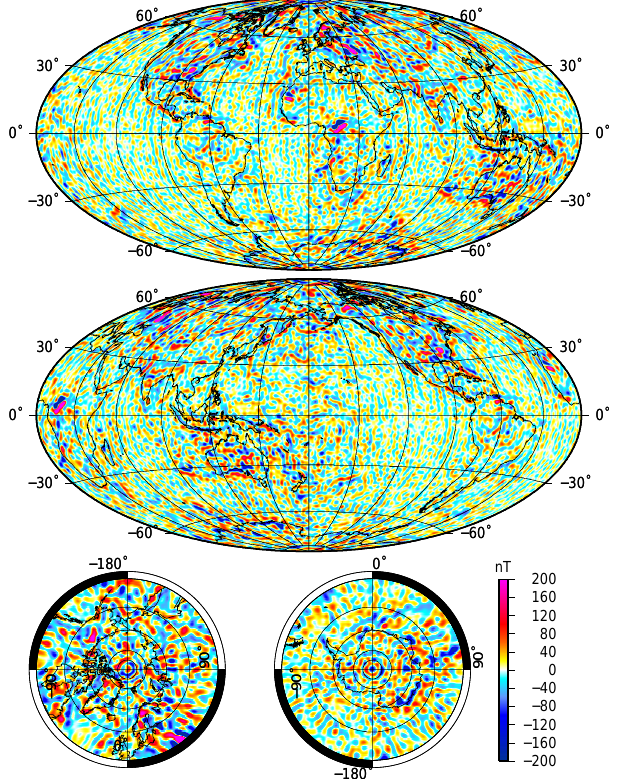
Fig. 8. Map of the vertical down components of the final litho- spheric field model B i . The map has been calculated at the Earth’s surface (6371.2km). Although some noise is still visible in the northern Atlantic and over the southern polar cap, the noise level over mid-latitudes has been greatly reduced. Anomalies are partic- ularly well defined over continents, and Indian and Pacific